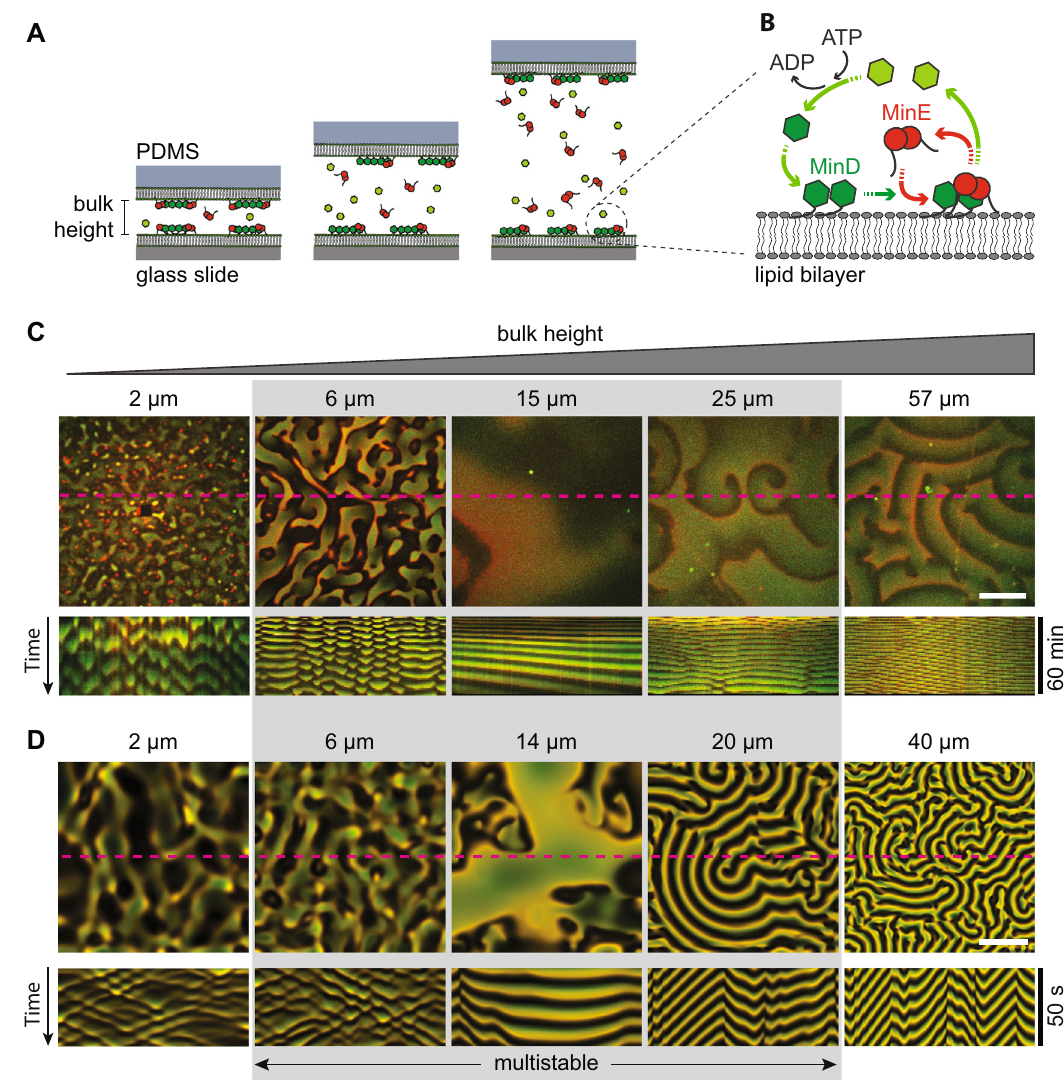
Fig. 1 Effect of a change of a bulk height on Min-pattern formation. A General concept of the experimental setup. MinD and MinE proteins were reconstituted in laterally large and fl at microchambers of different heights. All inner walls of microchambers were covered with supported lipid bilayers made of DOPC:DOPG:TFCL (66 : 32.99 : 0.01 mol%) mimicking the E. coli membrane composition. Min proteins cycle between bulk and the membrane upon which they self-organize into dynamic spatial protein-density patterns. B Min-protein interaction scheme. MinD monomers (light-green hexagons) bind ATP resulting in dimerization and cooperative accumulation on membrane (dark-green hexagons). Next, MinE dimers bind to MinD, activating its ATPase activity, detachment from the membrane, and diffusion to the bulk where ADP is exchanged to ATP, and the cycle repeats. C In fl uence of the bulk height on Min-pattern formation. Snapshots show overlays of MinD channel (green) and MinE channel (red) imaged on the membrane 30 min after injection. Kymographs below were generated along the dashed magenta lines. In each microchamber, the concentrations of the reconstituted proteins are 1 μ M MinE and 1 μ M MinD (corresponding to a 1:1 E : D ratio). The gray shaded area marks the range of bulk heights where different patterns are observed in repeated experiments (multistability), cf. Fig. 3. D Snapshots and kymographs from numerical simulations of the reaction-diffusion model describing the skeleton Min-model in a three-dimensional box geometry with a membrane on top and bottom surfaces and re fl ective boundaries at the sides (see Supplementary Methods 1 and 3 for details). The colors are an overlay of MinD density (green) and MinE density (red) on the top membrane. Parameters (from left to right): H = 2 μ m, E : D = 0.8; H = 6 μ m, E : D = 0.75; H = 14 μ m, E : D = 0.75; H = 20 μ m, E : D = 0.725; H = 40 μ m, E : D = 0.625. Lateral system dimensions: 200 × 200 μ m. The remaining, fi xed model-parameters are given in Supplementary Table 1. (White scale bars in C and D : 50 μ patterns that can be identi fi ed qualitatively by simple visual were covered with supported lipid bilayers composed of DOPG: inspection: standing wave chaos, homogeneous oscillations, and DOPC (3:7), which has been shown to mimic the natural E. coli traveling (spiral) waves. Moreover, for intermediate bulk heights membrane composition 23 . Proteins were administered by rapid injection of a solution containing 1 μ M of MinE and 1 μ M of (range shaded in gray in Fig. 1) we observe that the system has MinD proteins, together with 5 mM ATP and an ATP- the capacity to robustly exhibit different pattern types for the regeneration system 21 . same conditions (parameters). This multistability is discussed Figure 1C and Supplementary Movie 1 show snapshots and further below. kymographs of the characteristic patterns observed in micro- For low bulk heights (2 – 6 μ m in Fig. 1C) we observe chambers of different heights. We clearly observe distinct Min incoherent wave fronts of the protein density propagating from